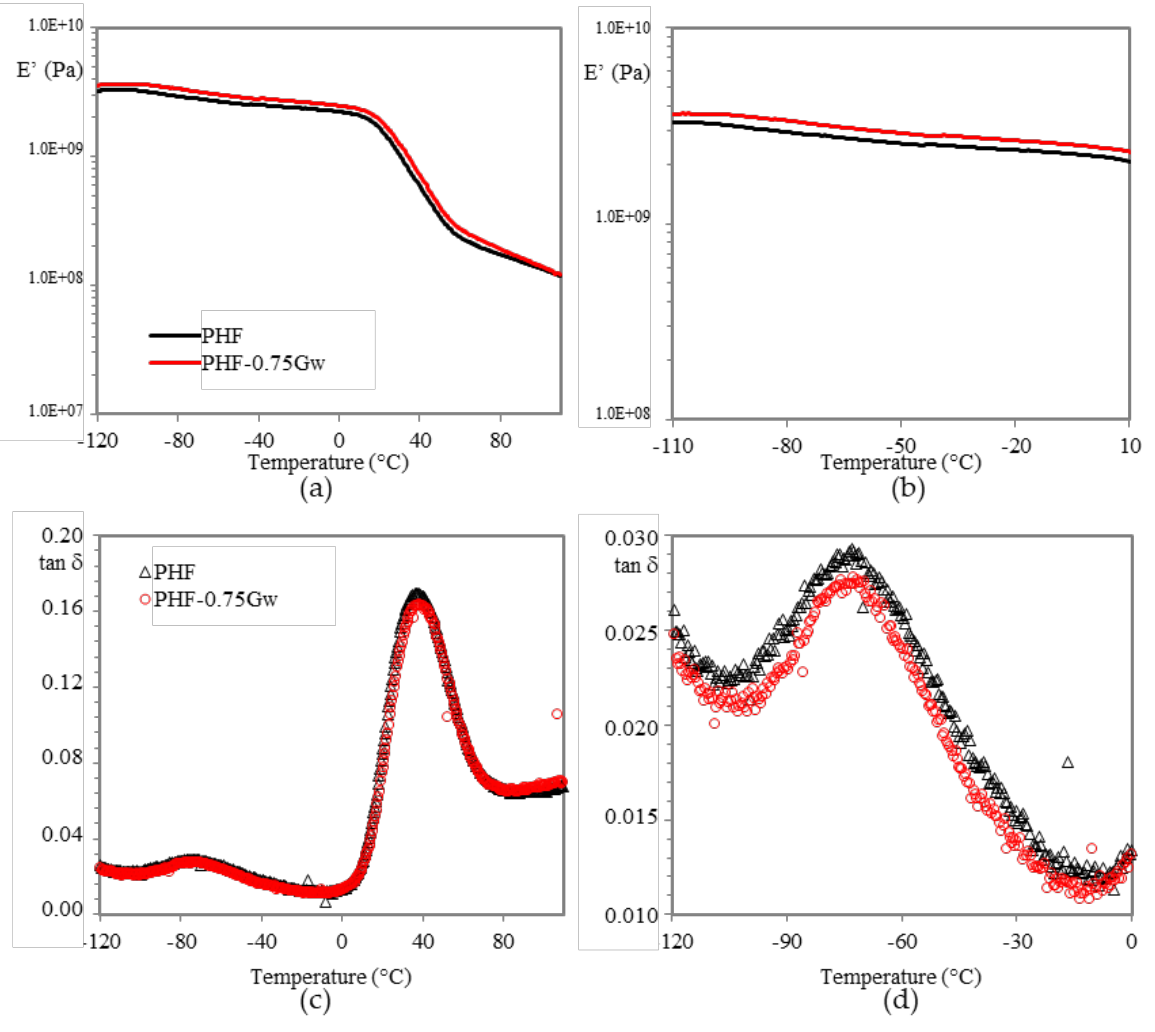
Figure 10. ( a ) Storage modulus E’ vs. T in PHF composites and ( b ) zoomed region; ( c ) tan δ vs. T and ( d ) zoomed region.